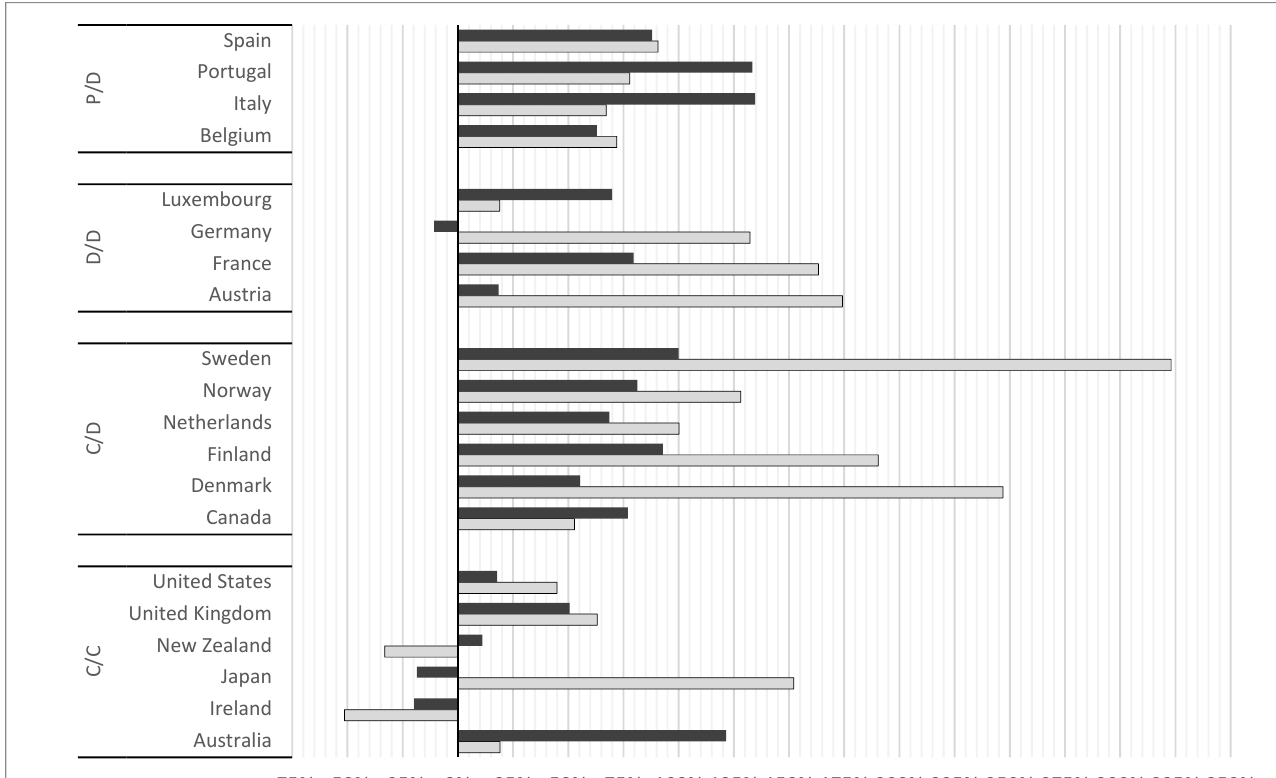
Figure 4. Percent change in household wealth and household debt, 1995*–2019. Source: International Monetary Fund (2020); OECD (2021a). Note: Asset data for New Zealand are unavailable before 2007 and unavailable for Ireland before 2001. Household debt data available for Luxembourg begin in 2002. Percent change calculation for each of these nations is baseline to those years.